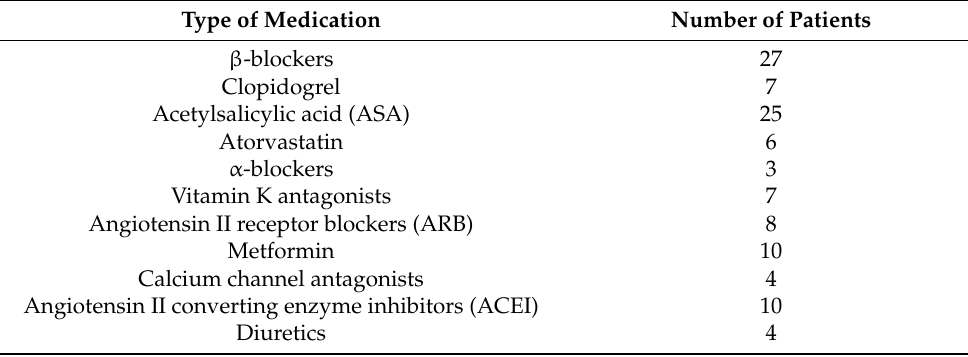
Table 3. Pharmacological treatment of male